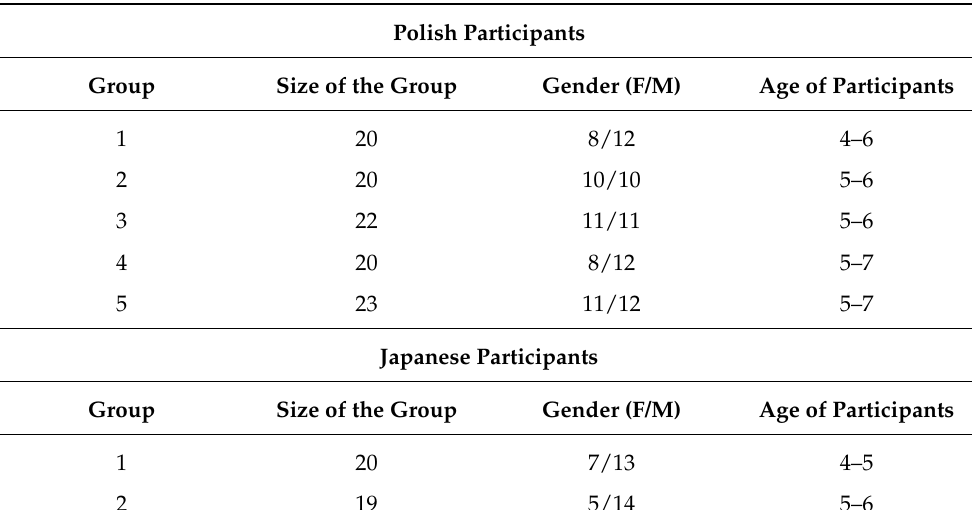
Table 1. The demographic data about the